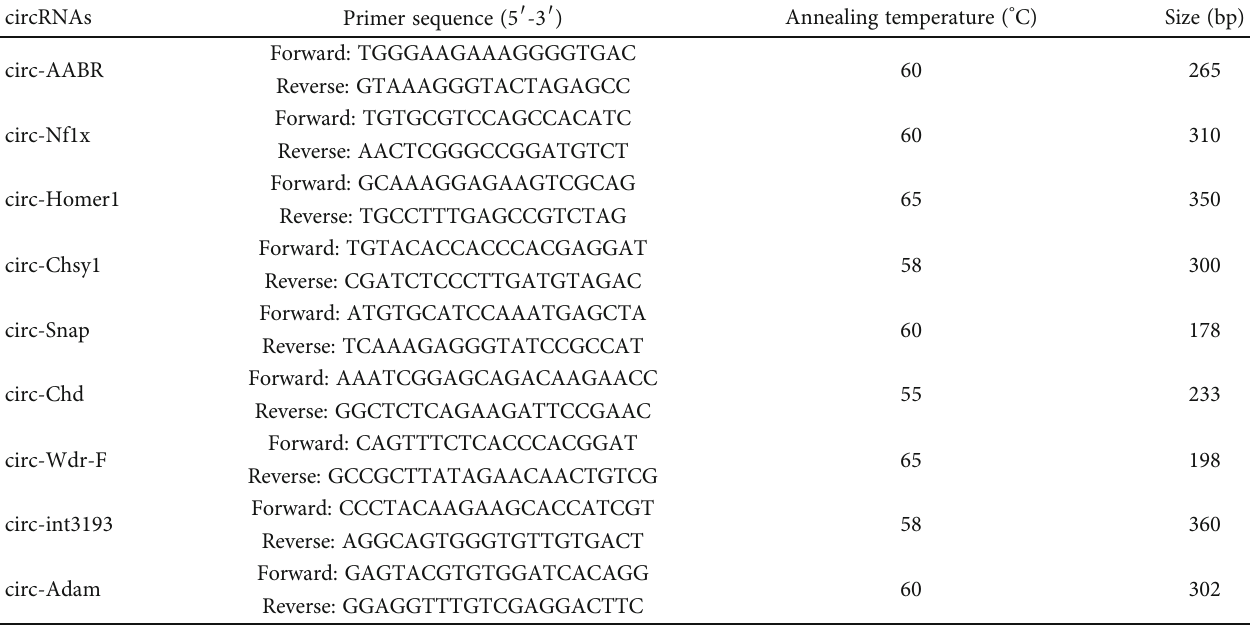
Table 1: List of divergent primers designed for RT-PCR validation of